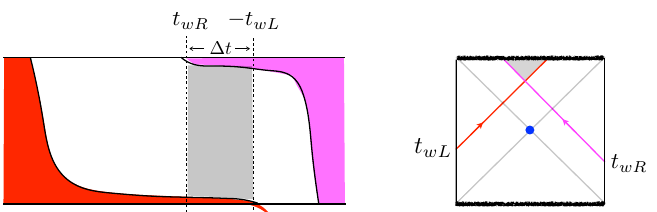
Figure 5 . Left Panel: the red perturbation from the left and the pink perturbation from the right have some overlap in the quantum circuit. Right Panel: the two perturbations meet in the black hole interior. It has been proposed that the number of gates in the grey region on the left is related to the spacetime volume of the grey region on the right.